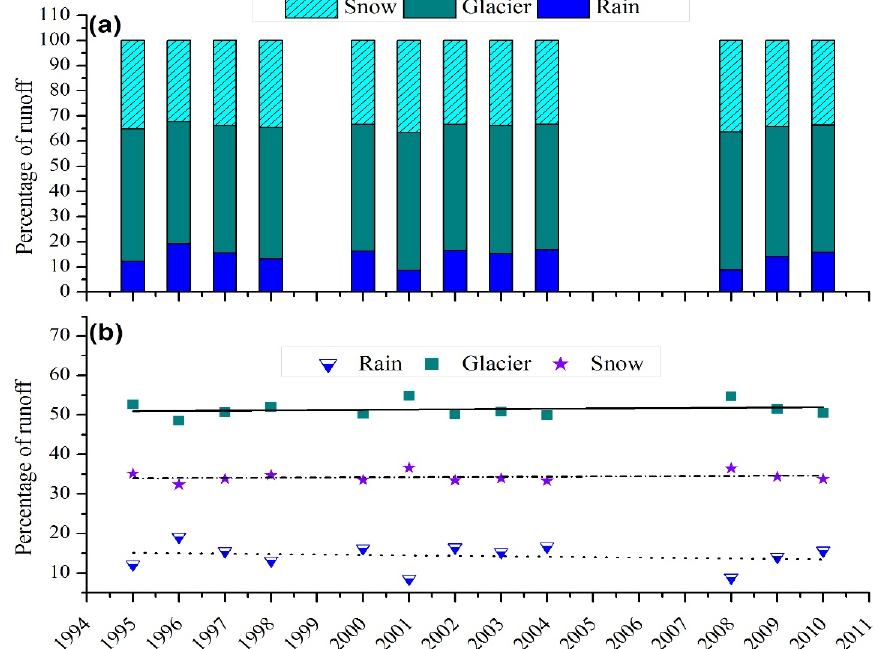
Figure 11. Annual variations in runoff components between 1995 and 2010. ( a ): stacked percent snow, glacier melt runoff along with percent rainfall runoff of the respective years, ( b ): percent runoff components of the respective years.